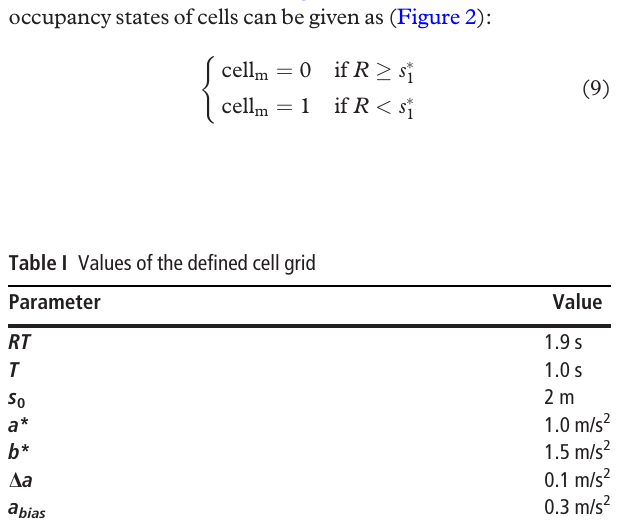
Figure 1 Illustration of the occupancy cells of LC scenarios Ego vehicle